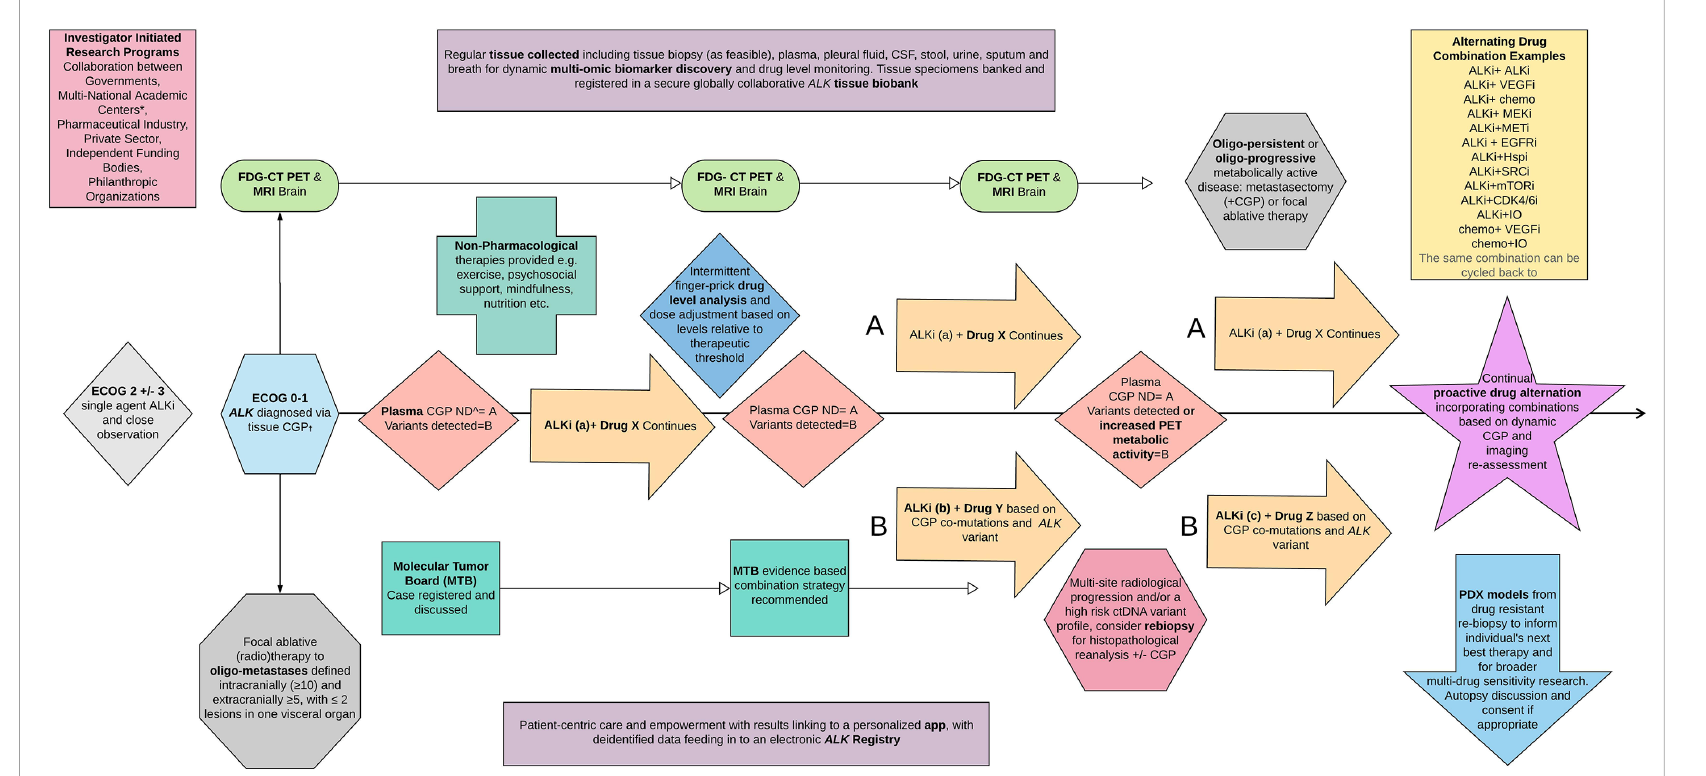
FIGURE 1 ALKTERNATE 2.0. A proposed novel dynamic multi-modality therapeutic trial algorithm and embedded translational program to inform a new paradigm for treating advanced ALK moving forward. ECOG, Eastern Cooperative Oncology Group performance status scale; CGP, complex genomic pro fi ling panel; ND, nil detected; PDX, patient-derived xenograft models, most commonly